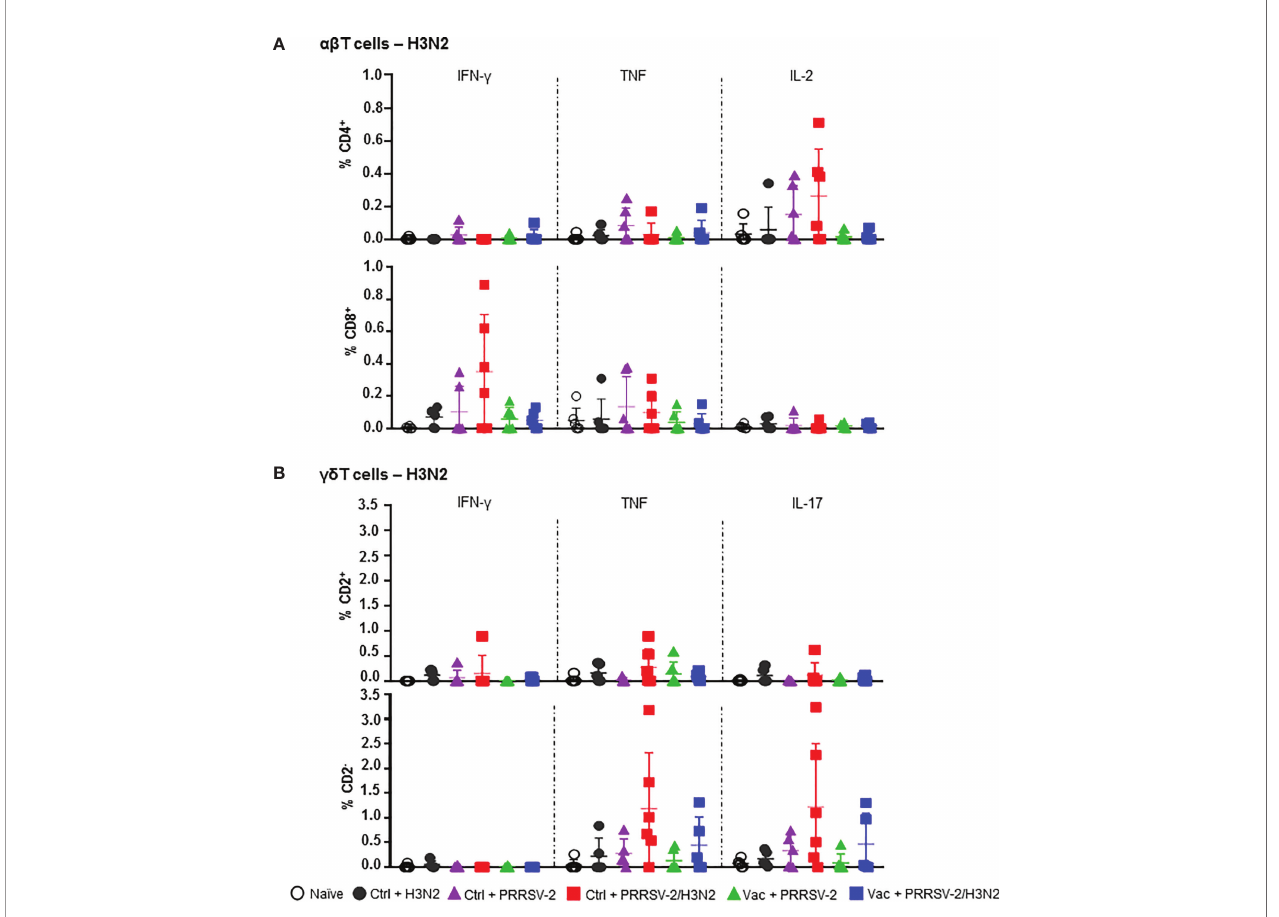
FIGURE 6 | H3N2-speci fi c T cell responses in bronchoalveolar lavage. Cells isolated from BALF at 5 dpc were restimulated with swIAV H3N2 (MOI 0.1) or cultured with medium. Cytokine secretion measured in CD4 + and CD8 b + (A) , and CD2 + and CD2 - gd (B) T cells are represented. Corrected frequencies of individual value and the mean ± SD are displayed (n = 5-6 per group). Comparisons between 2 groups were made using the Mann-Whitney